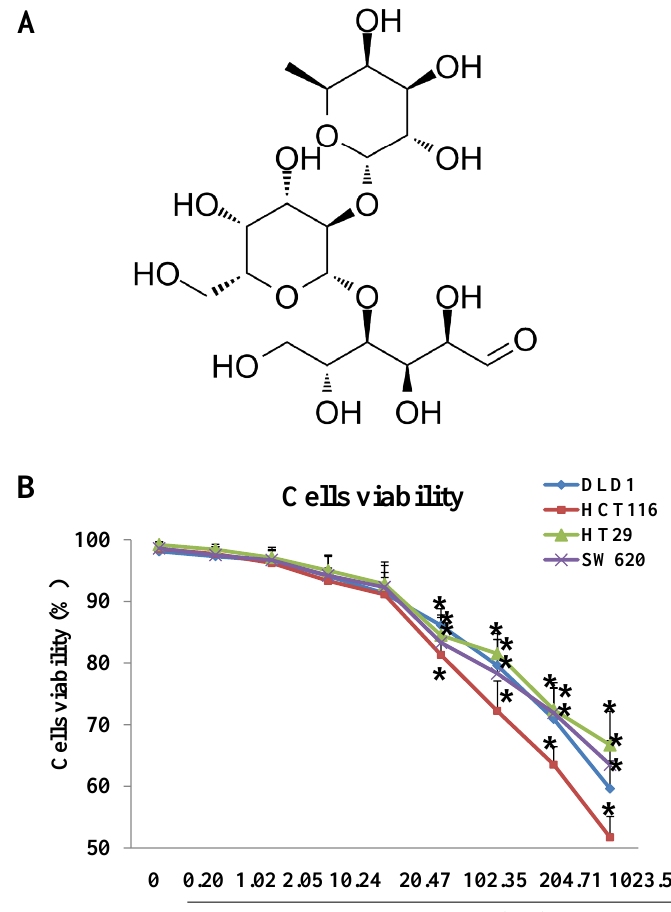
Figure 1. The effects of 2′ -FL on cell survival rate in DLD1, HCT116, HT29, and SW620 cells models. ( A ) Chemical structure of 2′ -FL. ( B ) DLD1, HCT116, HT29, and SW620 cells survival rates affected by 2′ -FL with different concentrations. All data in ( B ) are presented as mean ± SD, * p < 0.05 compared with the control group (0 mg/L), n = 4.